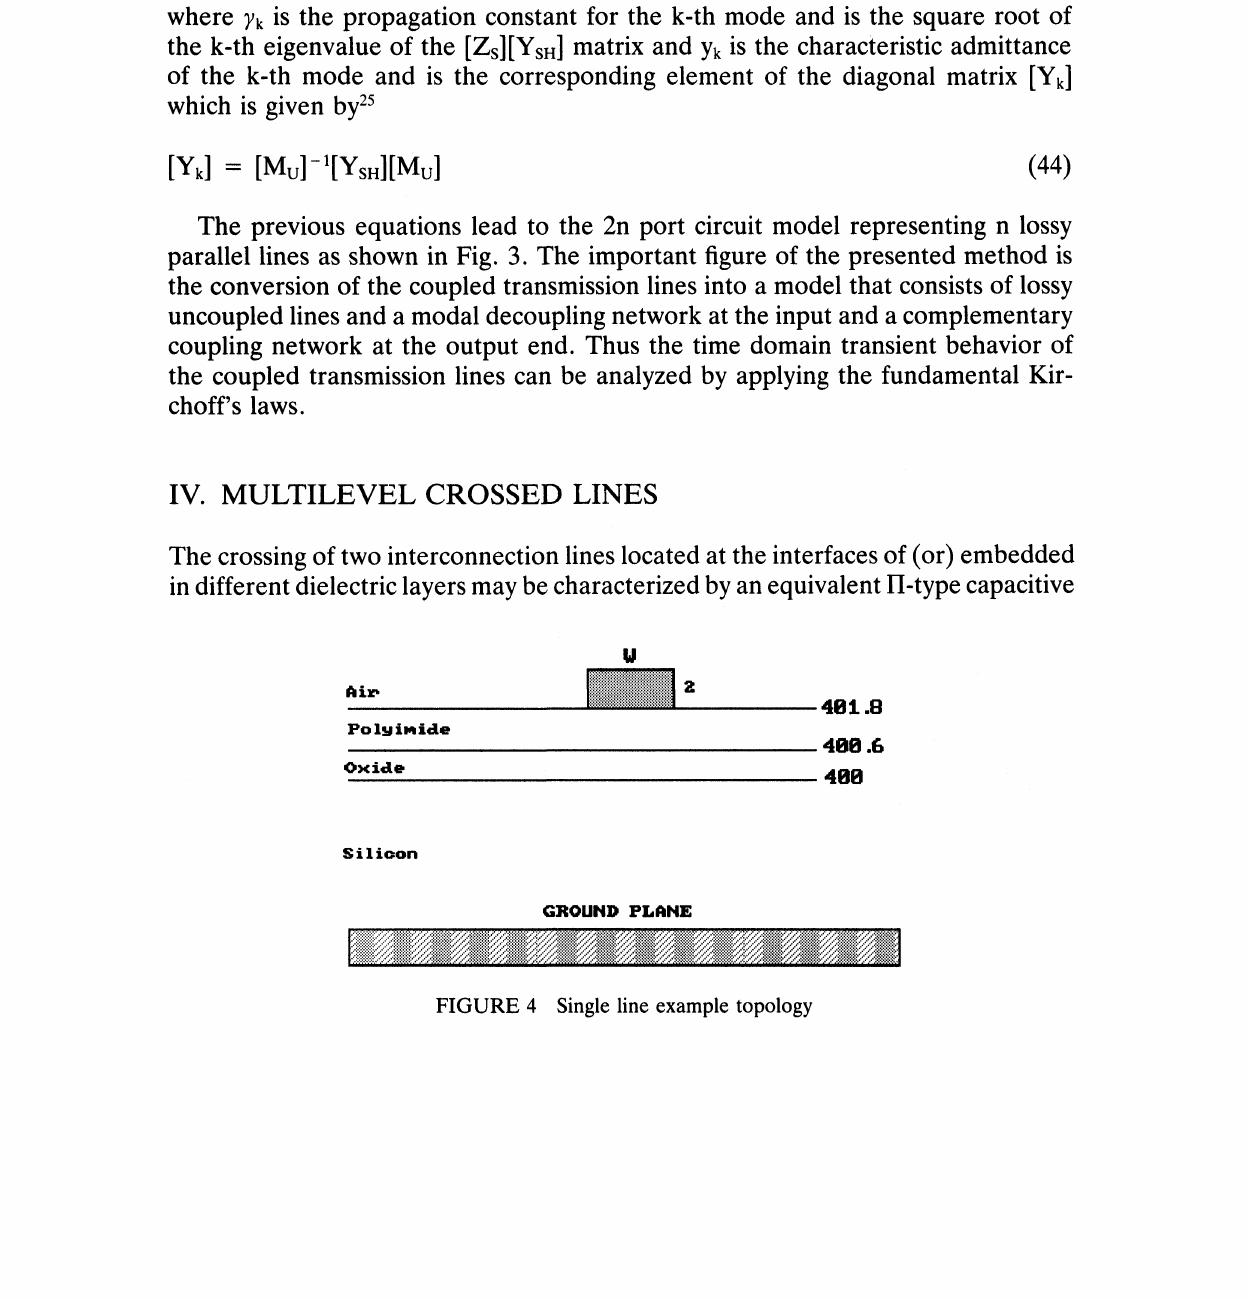
FIGURE 4 Single line example